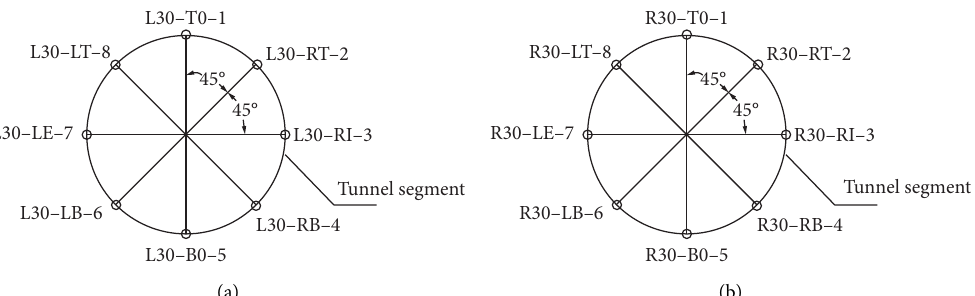
Figure 5: Monitoring points arrangement of each monitoring cross-section. (a) The 30th ring monitoring point on the left line. (b) The 30th ring monitoring point on the right